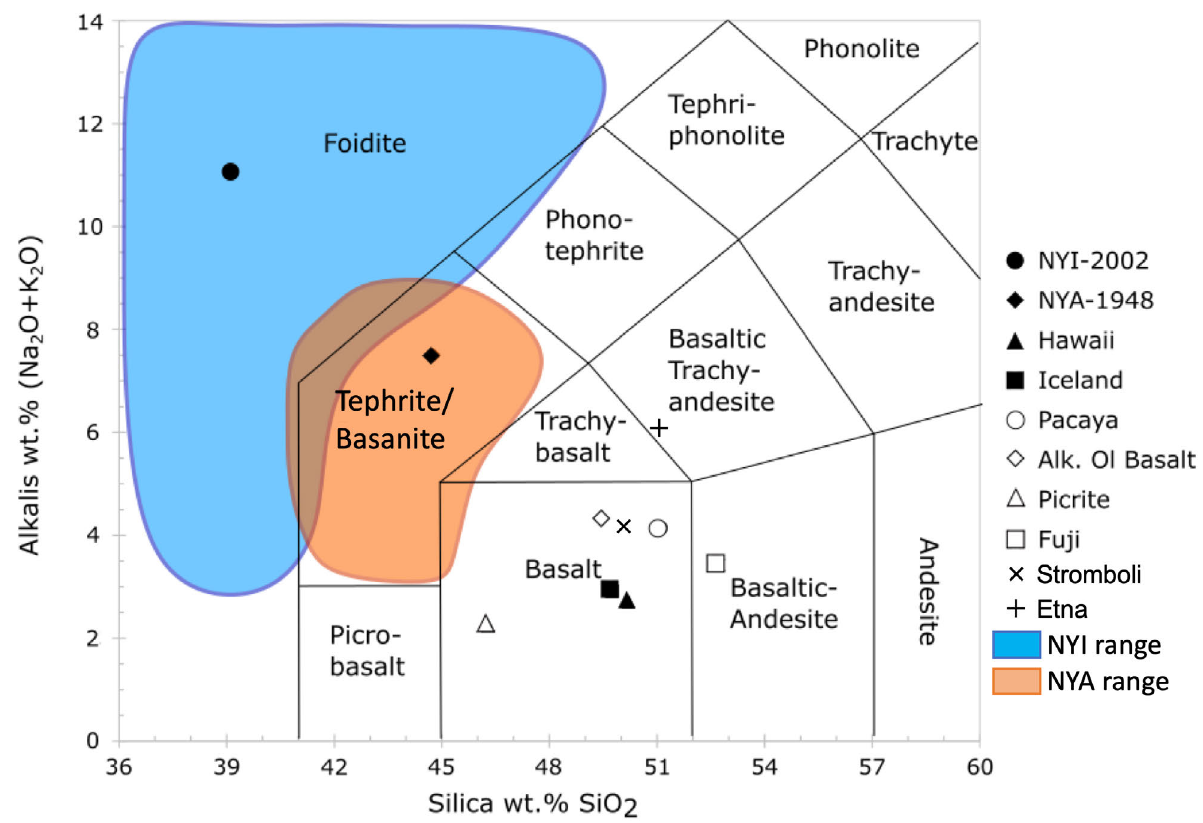
Figure 2: TAS diagram plotting compositions of this study (NYI-2002 and NYA-1948) in relation to some of the other mafic compositions that have experimental measurements of rheology (Hawaii: Sehlke et al. [2014]; Iceland: Kolzenburg et al. [2017]; Pacaya: Soldati et al. [2016]; Alkaline Olivine Basalt: Ishibashi and Sato [2007]; Picrite: Ryerson et al. [1988]; Fuji: Ishibashi and Sato [2010]; Stromboli and Etna: Vona et al. [2011]). The range of compositions for both Nyiragongo lavas and Nyamuragira lavas, from Barette et al. [2017], are shown as blue and orange fields